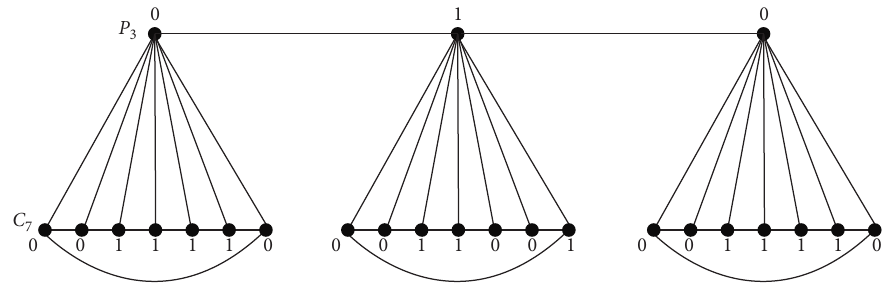
Figure 28: Logical labeling of P